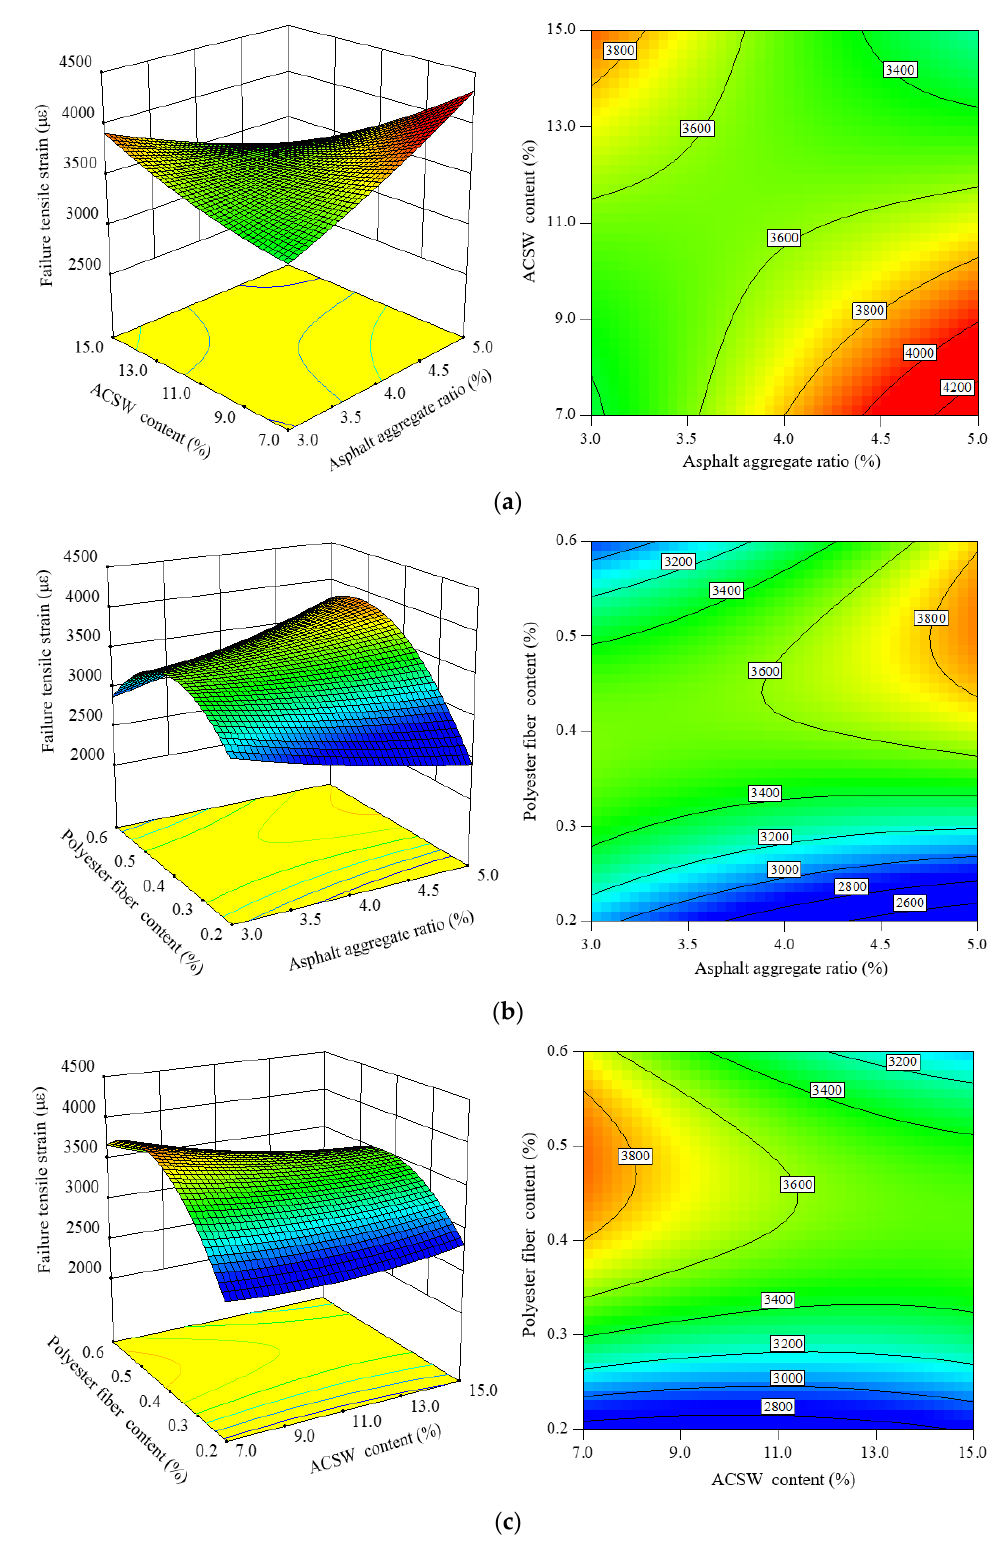
Figure 9 evaluates the effect of three design parameters on failure tensile stain ( FTS ) response 3D and 2D maps.